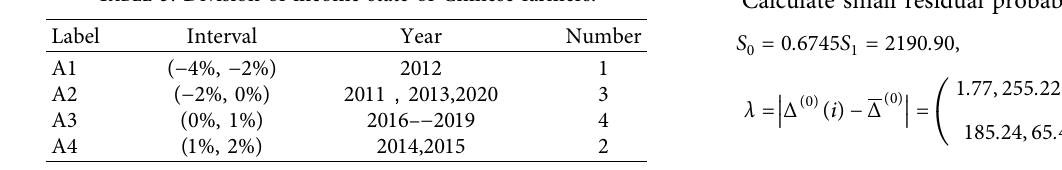
Figure 4: The grey system prediction results of per capita dis- posable income of rural residents in China from 2021 to 2025. Table 3: Division of income state of Chinese